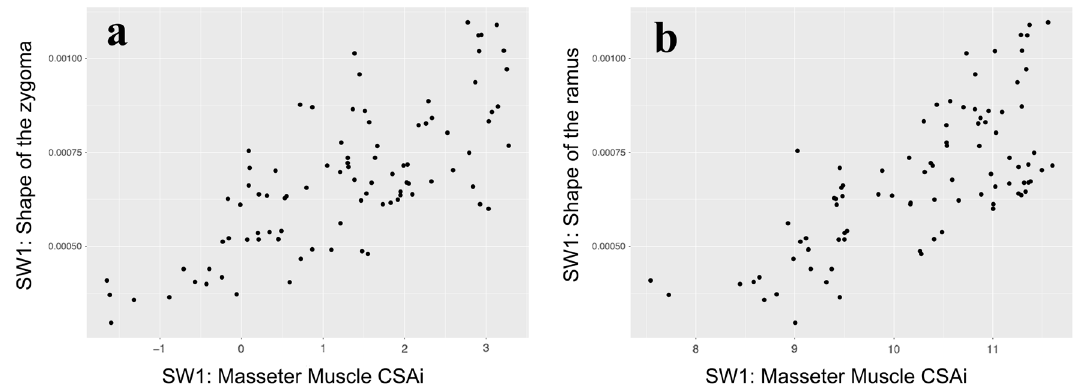
Figure 4. Masseter muscle—facial bone integration. Plots of singular warp (SW1) of the CSAi of the masseter muscle (x-axis) against SW1 of the shape of the zygoma ( a, y-axis) and the ramus of the mandible ( b, y-axis). Scores on these axes are significantly correlated (r = 0.737; RV = 0.506; P = 0.0001; 95% confidence interval = 0.625, 0.819 and r = 0.725; RV = 0.408; P = 0.0001; 95% confidence interval = 0.609, 0.81,